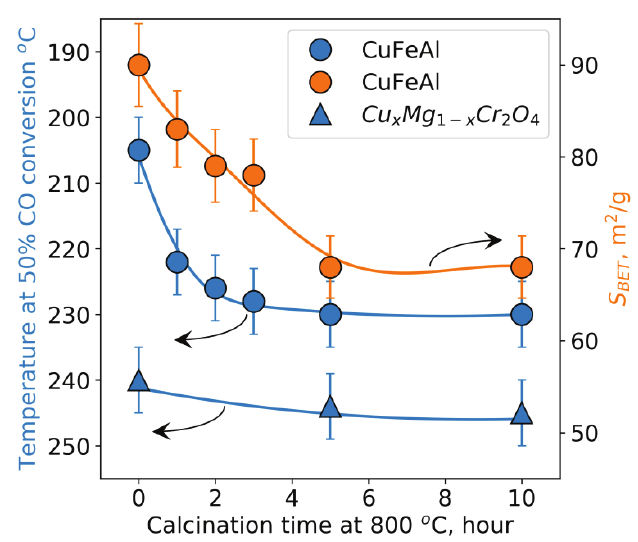
Figure 4. Dependence of activity (the blue curves and circles) and specific surface area (the orange